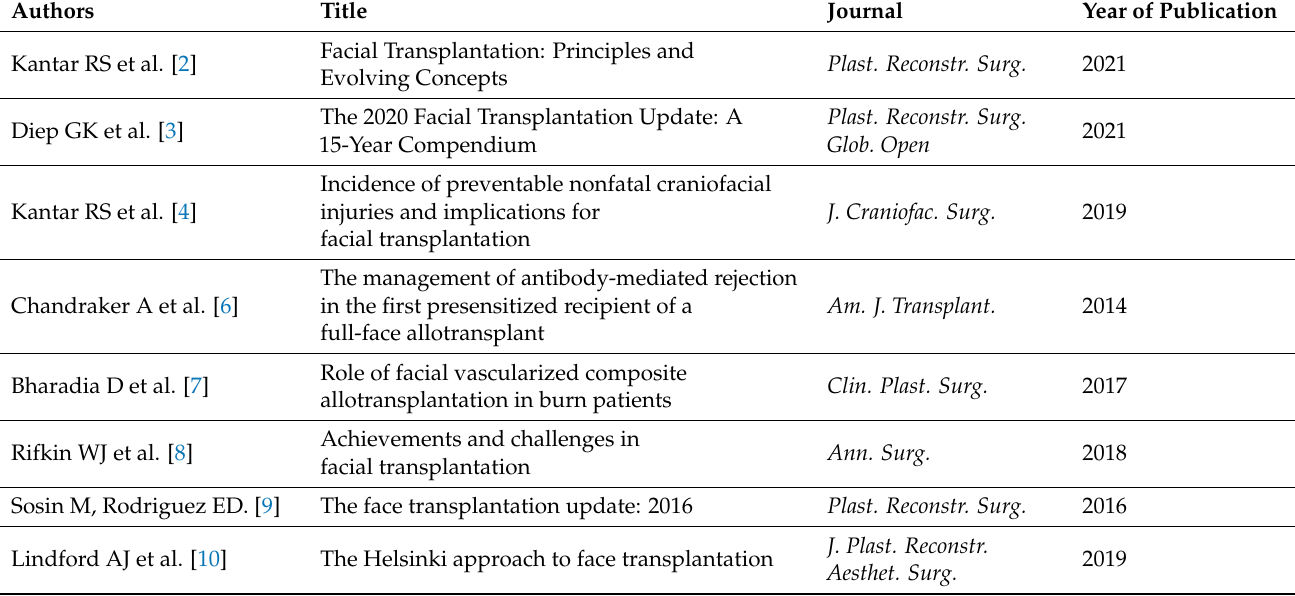
Table 1. Studies included in the